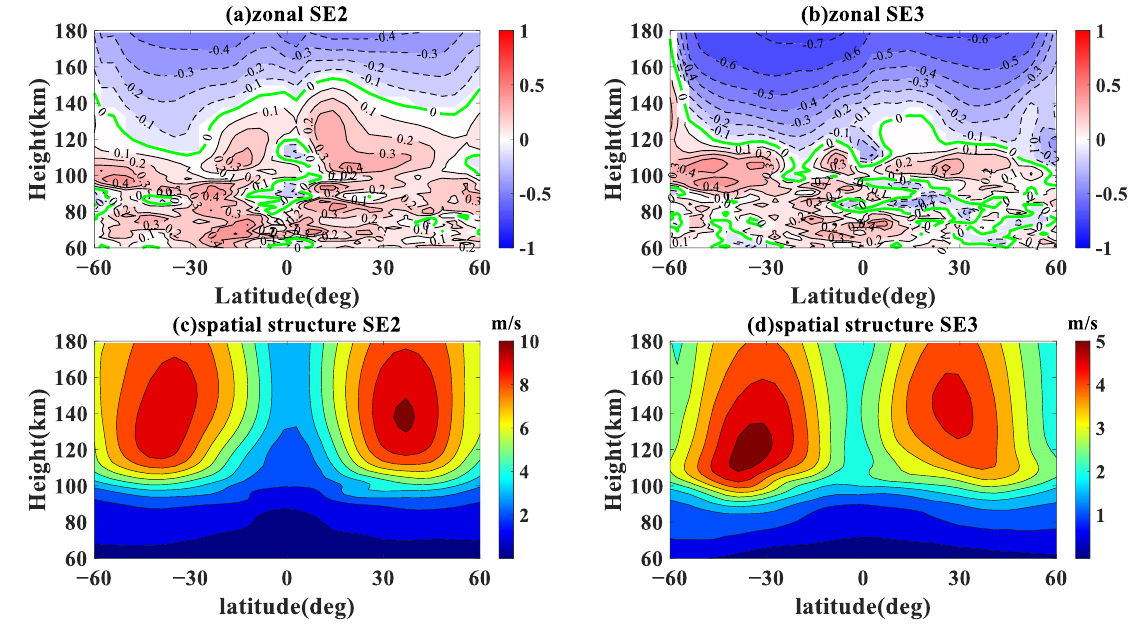
Figure 4. The correlation between non-migrating tidal variations ( a ) SE2 and ( b ) SE3 and F10.7 cm index between 60 ° S and 60 ° N from 2003 to 2019. The spatial structure between 60 ° S and 60 ° N from 2003 to 2019 for ( c ) SE2 and ( d ) SE3.